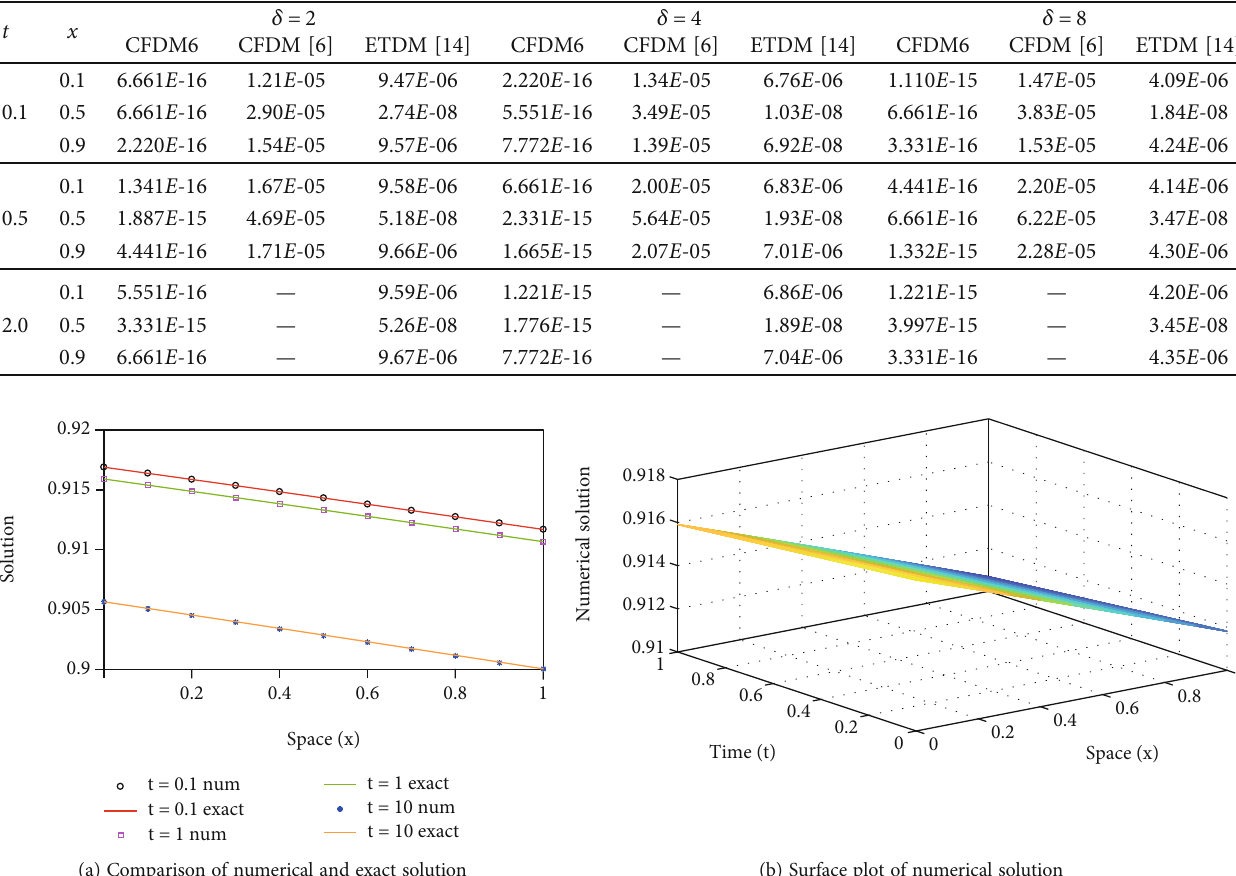
Table 3: Comparison of absolute error of Example 3 with β = 0 : 1 , γ = − 0 : 0025 , h = 0 : 1 , and Δ t = 0 : 0001 .